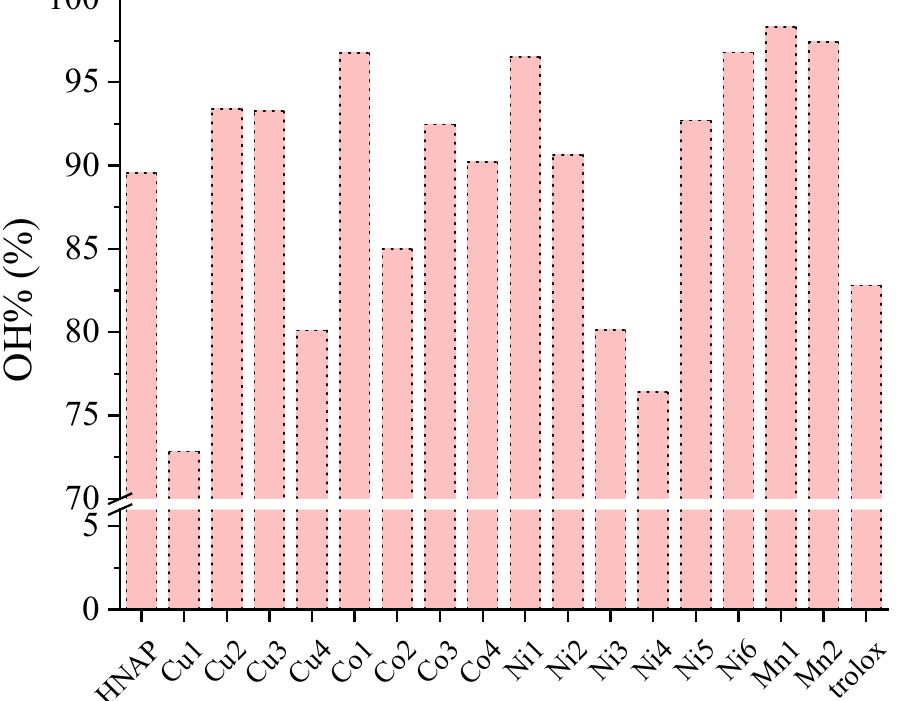
Figure 25. Hydroxyl radicals’ scavenging activity (OH%) of naproxen and its reported complexes. (Codes of compounds: HNAP = naproxen; Cu1 = [Cu 2 (NAP) 4 (H 2 O) 2 ]; Cu2 = [Cu(NAP) 2 (py) 2 (H 2 O)]; Cu3 = [Cu(NAP) 2 (phen)] · H 2 O; Cu4 = [Cu(NAP) 2 (bipy)] · H 2 O; Co1 = [Co(NAP) 2 (CH 3 OH) 4 ]; Co2 = [Co(NAP) 2 (py) 2 (H 2 O) 2 ]; Co3 = [Co(NAP) 2 (phen)(H 2 O) 2 ]; Co4 = [Co(NAP) 2 (bipy)(H 2 O) 2 ]; Ni1 = [Ni(NAP) 2 (CH 3 OH) 4 ]; Ni2 = [Ni(NAP) 2 (bipy)(CH 3 OH)]; Ni3 = [Ni(NAP) 2 (phen)(H 2 O)]; Ni4 = [Ni(NAP) 2 (bipyam)]; Ni5 = [Ni(NAP) 2 (Hpko) 2 ]; Ni6 = [Ni(NAP) 2 (py) 2 (H 2 O) 2 ]; Mn1 = [Mn(NAP) 2 (py) 2 (H 2 O) 2 ] and Mn2 = [Mn(NAP) 2 (phen)(H 2 O)].). Among the complexes, those bearing nitrogen–donor co-ligands were significantly active, with the manganese(II) complexes [Mn(NAP) 2 (py) 2 (H 2 O) 2 ] (OH% = 98.31 ± 0.67%) and [Mn(NAP) 2 (phen)(H 2 O)] (OH% = 97.42 ± 0.83%) being the most potent hydroxyl